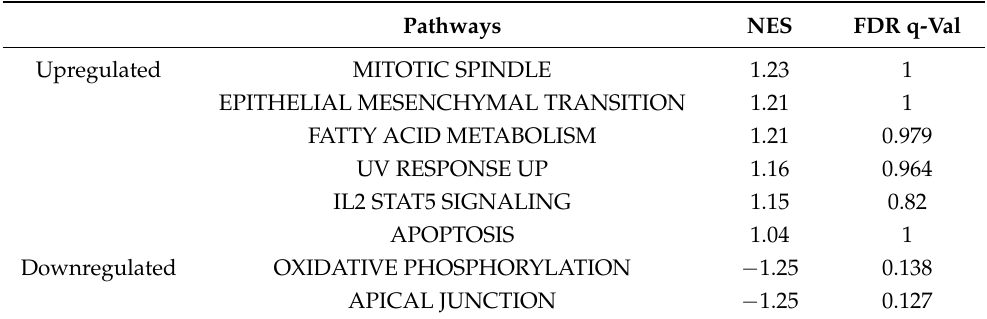
Table 1. Significant up and downregulated pathways in JTB upregulated condition in MCF7 BC cells, according to GSEA analysis with FDR < 25%. Pathways NES FDR q-Val Upregulated MITOTIC SPINDLE 1.23 EPITHELIAL MESENCHYMAL